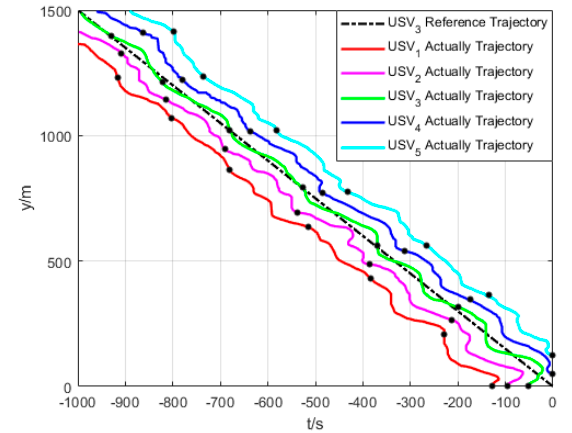
Figure 22. Formation trajectory (Algorithm 4).